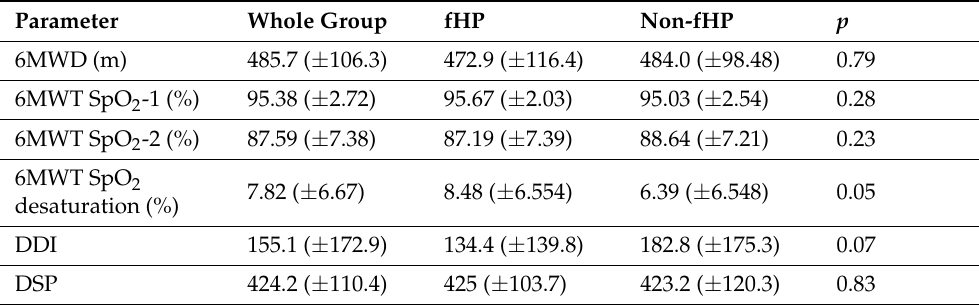
Table 3. Comparison of baseline 6MWT parameters (mean ± SD) in fibrotic versus non-fibrotic HP (Mann-Whitney test).